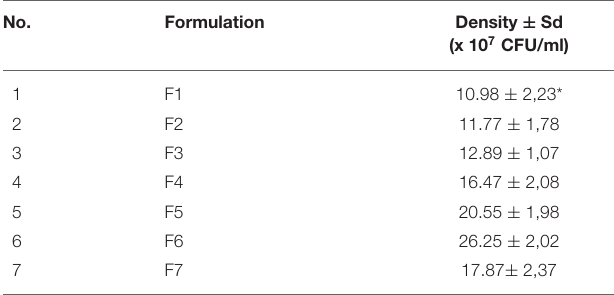
TABLE 2 | Population of Paenibacillus polymyxa C1 in respective formulation.